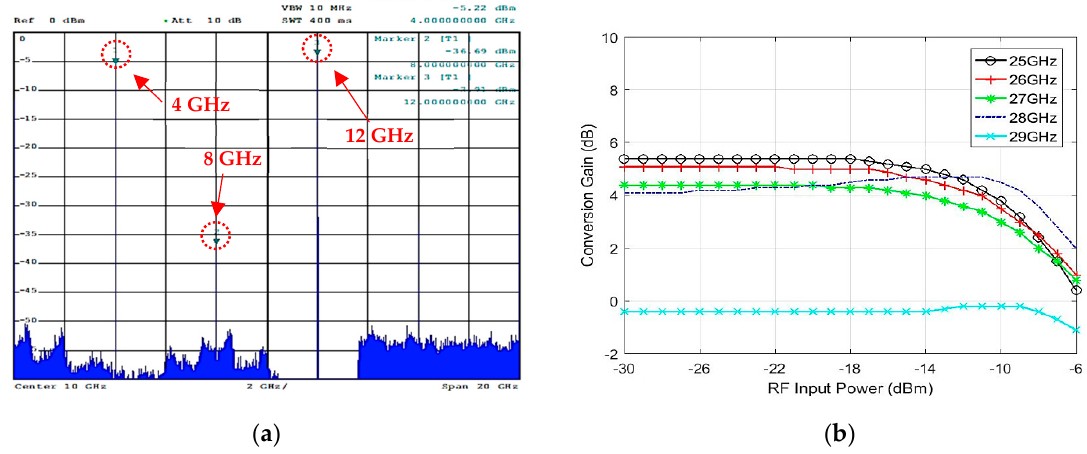
Figure 8. Measurements of downconverter module: ( a ) RF output spectrum (M1@4 GHz, M3@12 GHz; ( b ) downconverter conversion gain at different RF frequencies.